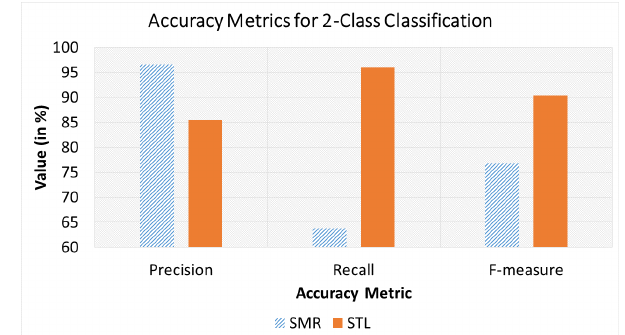
Figure 6: Precision, Recall, and F-Measure values using self-taught learning (STL) and soft-max re- gression (SMR) for 2-class when applied to test data